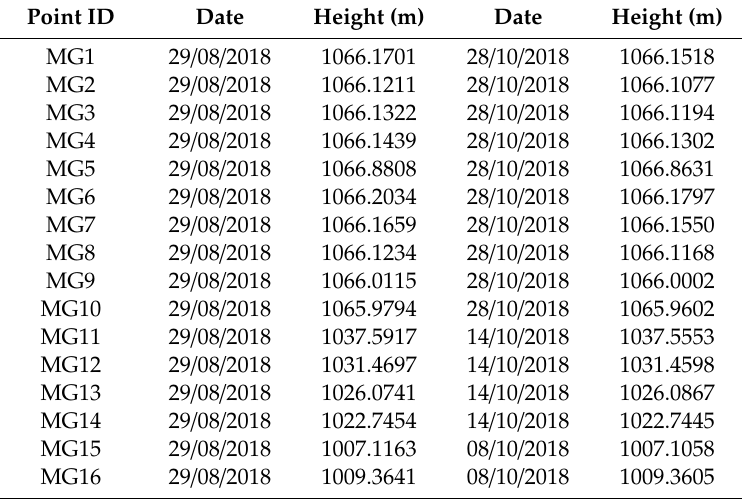
Table 1. Height values of points MG1 to MG16, relating to the start and end time of monitoring during the first filing of the reservoir.